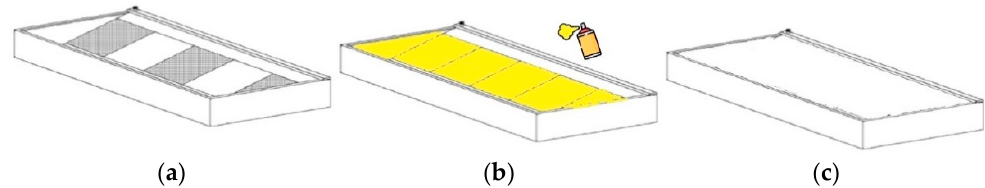
Figure 2. Picture of ( a ) filter before spraying the encapsulating agent; ( b ) colored film capable of blocking the fibers; ( c ) lifting jacks and closed sarcophagus for the safe transportation.